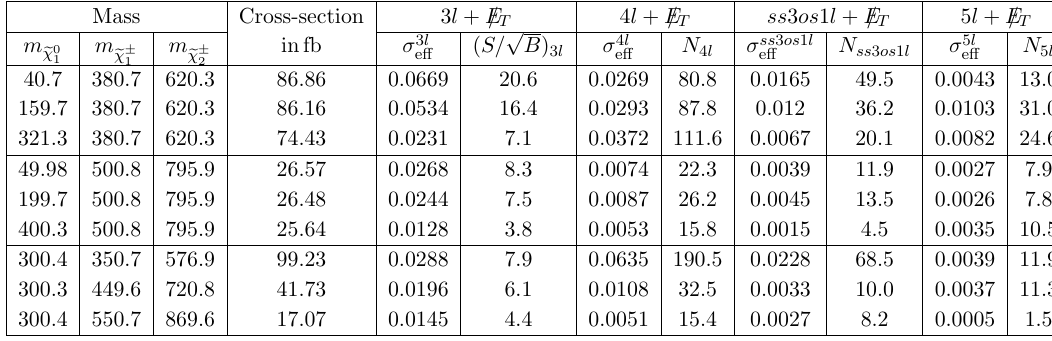
Table 6 . The masses and production cross-sections of all possible eweakino pairs for di(cid:11)erent BPs in the LHHS model are given. For the trilepton signal in each case we display the signi(cid:12)cance p ( S= B ). The corresponding (cid:27) e(cid:11) and total number of signal events (with negligible backgrounds) for each type of multilepton signal with n > 3 are also shown. Masses and cross-sections are in GeV and fb